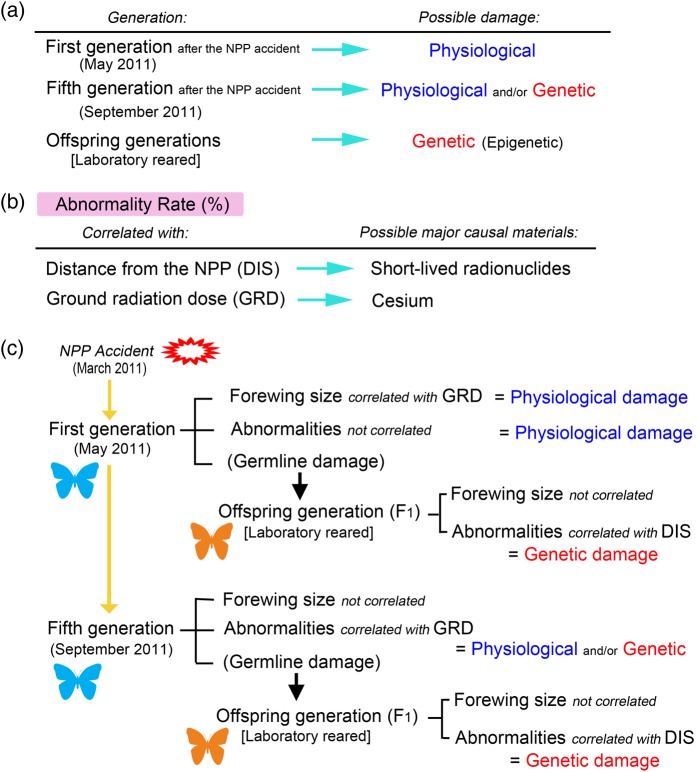
Interpretations of morphological examinations. (a) Judgment criteria regarding the nature of damage based on the generations examined. All of the morphological changes in the first generation can be attributed to physiological damage because the first generation directly received irradiation. Morphological changes observed in the laboratory reared (F1) generations from the first and fifth generations can be attributed to genetic damage because physiological damage did not occur in the clean laboratory environment; however, some of these changes may have been epigenetic. Morphological changes in the fifth generation may be a mixture of physiological and genetic damages. (b) Judgment criteria regarding the potential major causal materials. When abnormality rates are correlated with distance from the NPP, these abnormalities can be attributed to short-lived radionuclides because they are distributed in a concentric fashion. When abnormality rates are correlated with the measured ground radiation doses, these abnormalities can be attributed to the radioactive cesium species. (c) Summary of morphological examinations. Physiological (somatic) damage in the first generation is clearly detected. Genetic (germline) damage in the first and fifth generations is also clear, based on the results of the offspring generations. Genetic damage is likely caused by short-lived radionuclides, based on the correlation with distance. Abnormalities in the first generation may be caused by both short-lived radionuclides and cesium, which did not exhibit a clear correlation. Abnormalities in the fifth generation may primarily be caused by cesium.